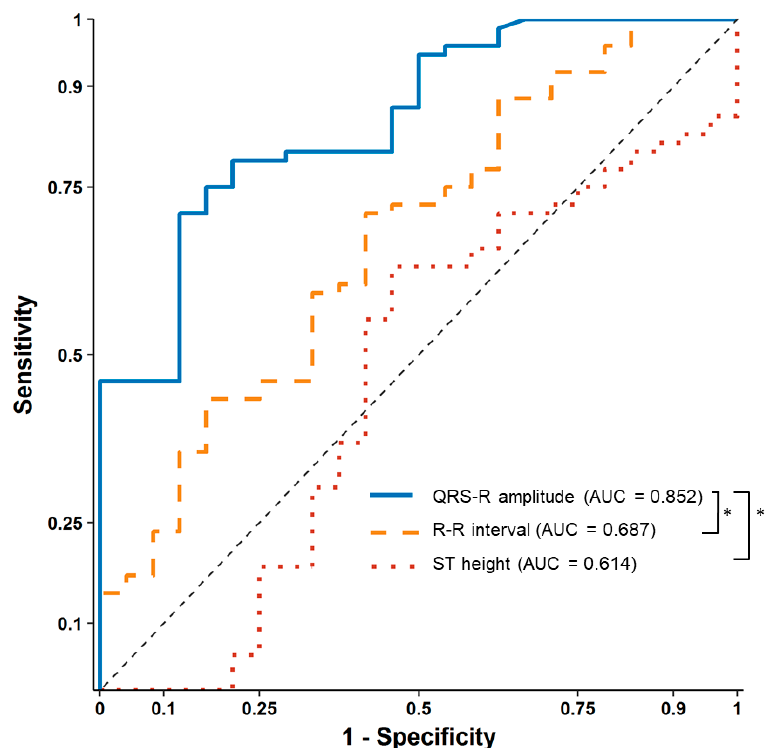
Figure 3. Receiver operating characteristic curve analysis of percentage changes in the QRS R-amplitude, ST height, and R–R interval in relation to ≥ 25% changes in systolic blood pressure. * Delong test, p < 0.001 compared to the QRS R-amplitude.